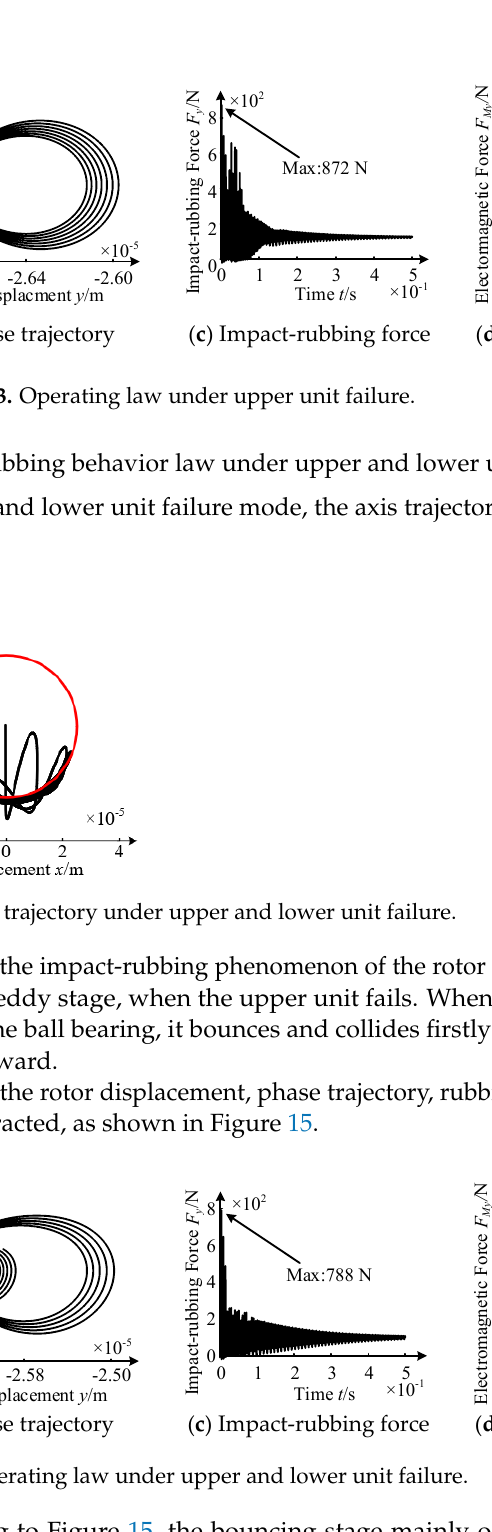
displacement and impact-rubbing force shake violently. The amplitude decreases gradu-